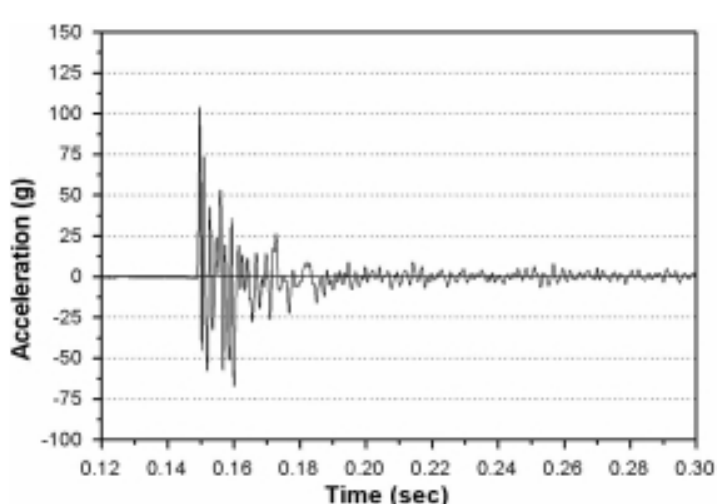
Fig. 8. Filtered(2.5 kHz) time-history